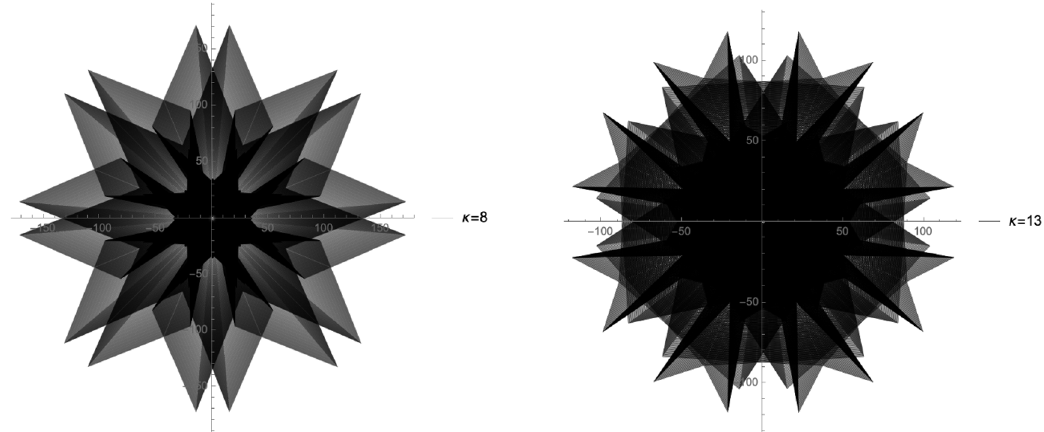
Figure 3 . Plot of Z with k = (cid:20) , (cid:16) = 0, m = 0 : 02 at (cid:12)xed (cid:20) and varying % . The points U(1) ; 1 % obtained from consecutive values of % are joined by a segment. Left: (cid:20) = 8, % = 1 ; : : : ; 2 (cid:2) 10 4 . Right: (cid:20) = 13, % = 1 ; : : : ; 10 4